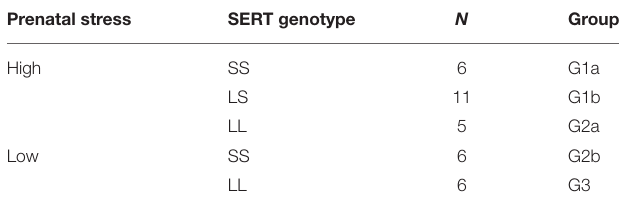
TABLE 1 | Comparison